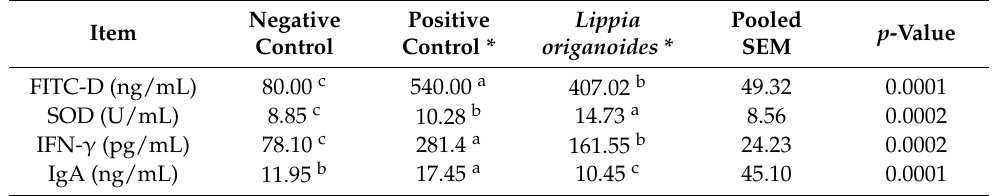
Table 5. Evaluation serum levels of fluorescein isothiocyanate dextran (FITC-d), superoxide dismu- tase (SOD), gamma interferon (IFN- γ ), and IgA in broiler chickens consuming a diet